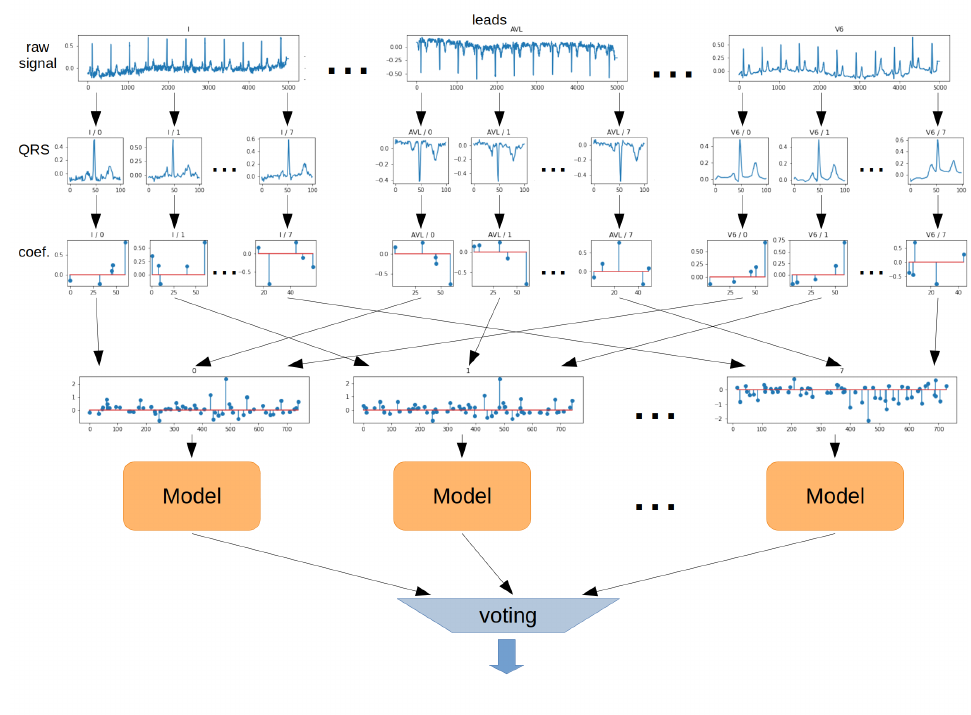
Figure 15. Aggregation method—Voting.